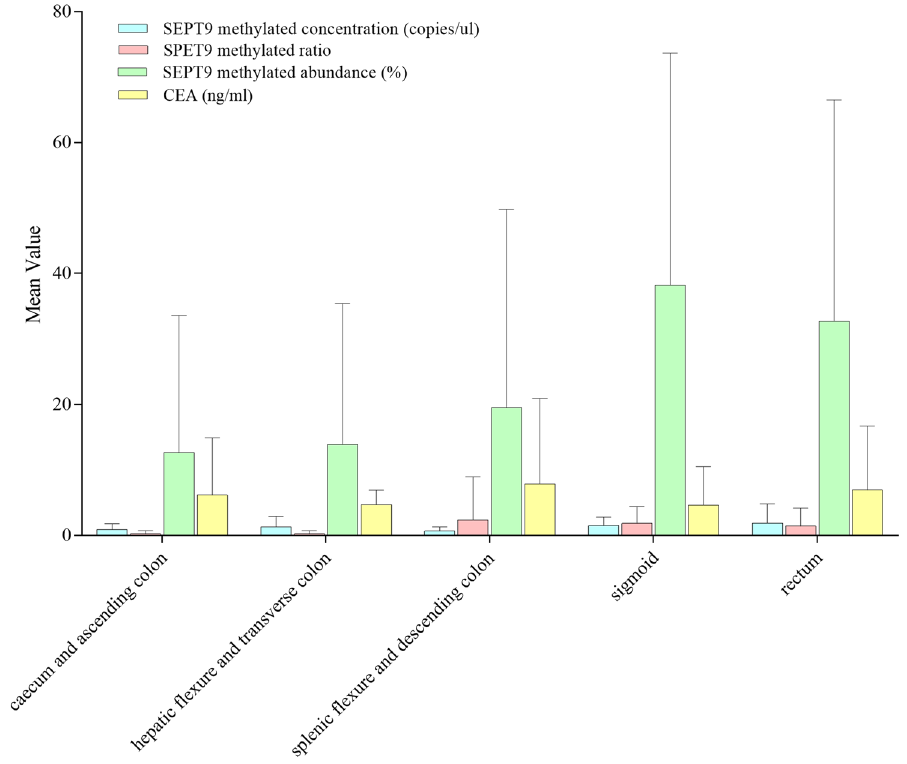
Figure 2. SEPT9 methylation and CEA levels in patients according to tumor locations. The mean values of pre-operative septin 9 (SEPT9) methylated concentration (blue), ratio (pink), abundance (green), and carcinoembryonic antigen (CEA, yellow) levels were shown for colorectal cancer (CRC) patients according to tumor locations from the caecum and ascending colon to the rectum. The methylated abundance increased from proximal to distal sites (Pearson Correlation Coefficient 0.25, P = 0.017) while SEPT9 methylated concentration, ratio and CEA had no such significant trend (Pearson Correlation Coefficient 0.16, 0.13 and 0.03; P = 0.11, 0.21 and 0.76, respectively).